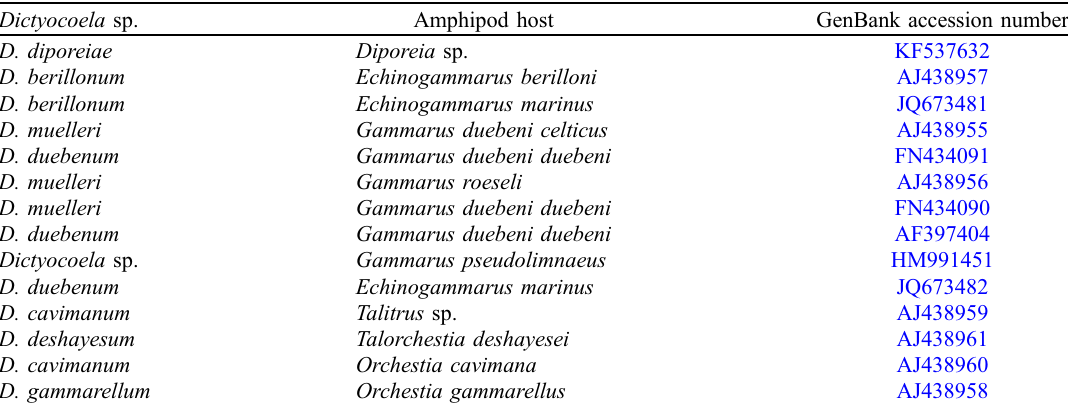
Table 1. Listing of host record for Dictyocoela diporeiae n. sp. and similar Dictyocoela strains. Dictyocoela sp.